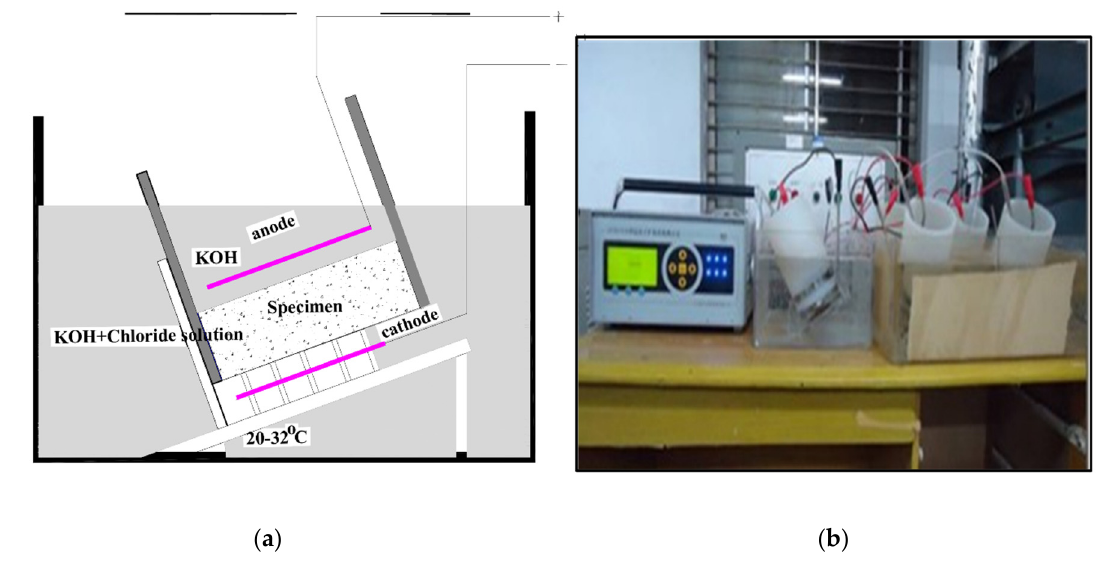
Figure 2. RCM-DAL chloride ion diffusion coefficient tester. ( a ) Operation schematic diagram; ( b ) equipment connection diagram.